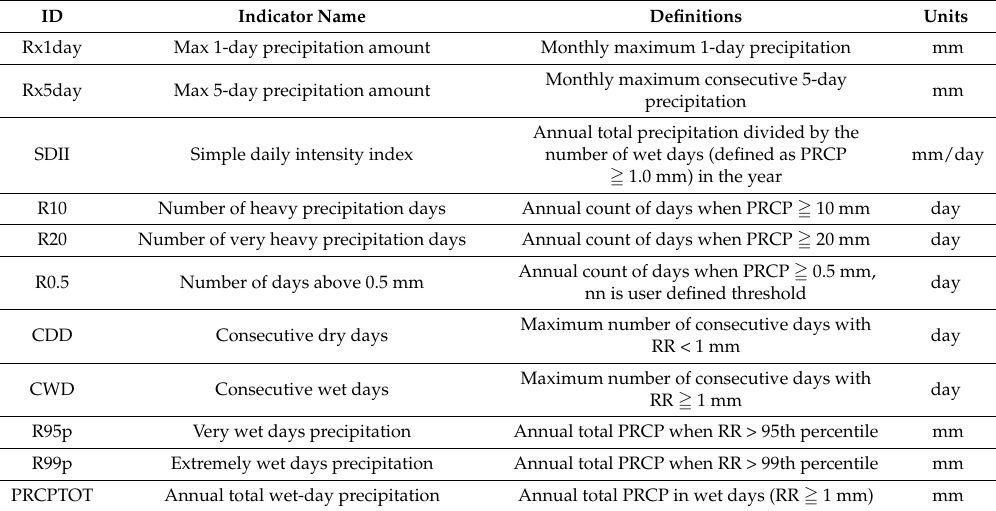
Table 1. Precipitation indices selected for this study with indicator names, definitions, and